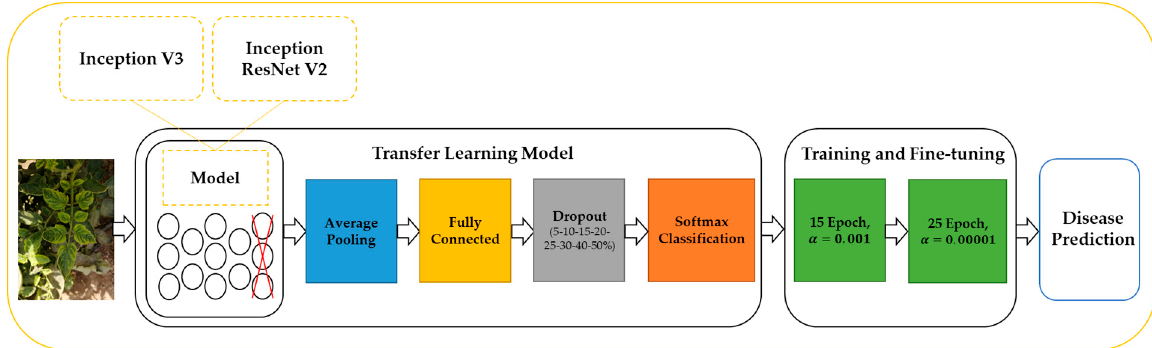
Figure 4. CNN architecture to develop a pre-trained model for tomato disease diagnosis.